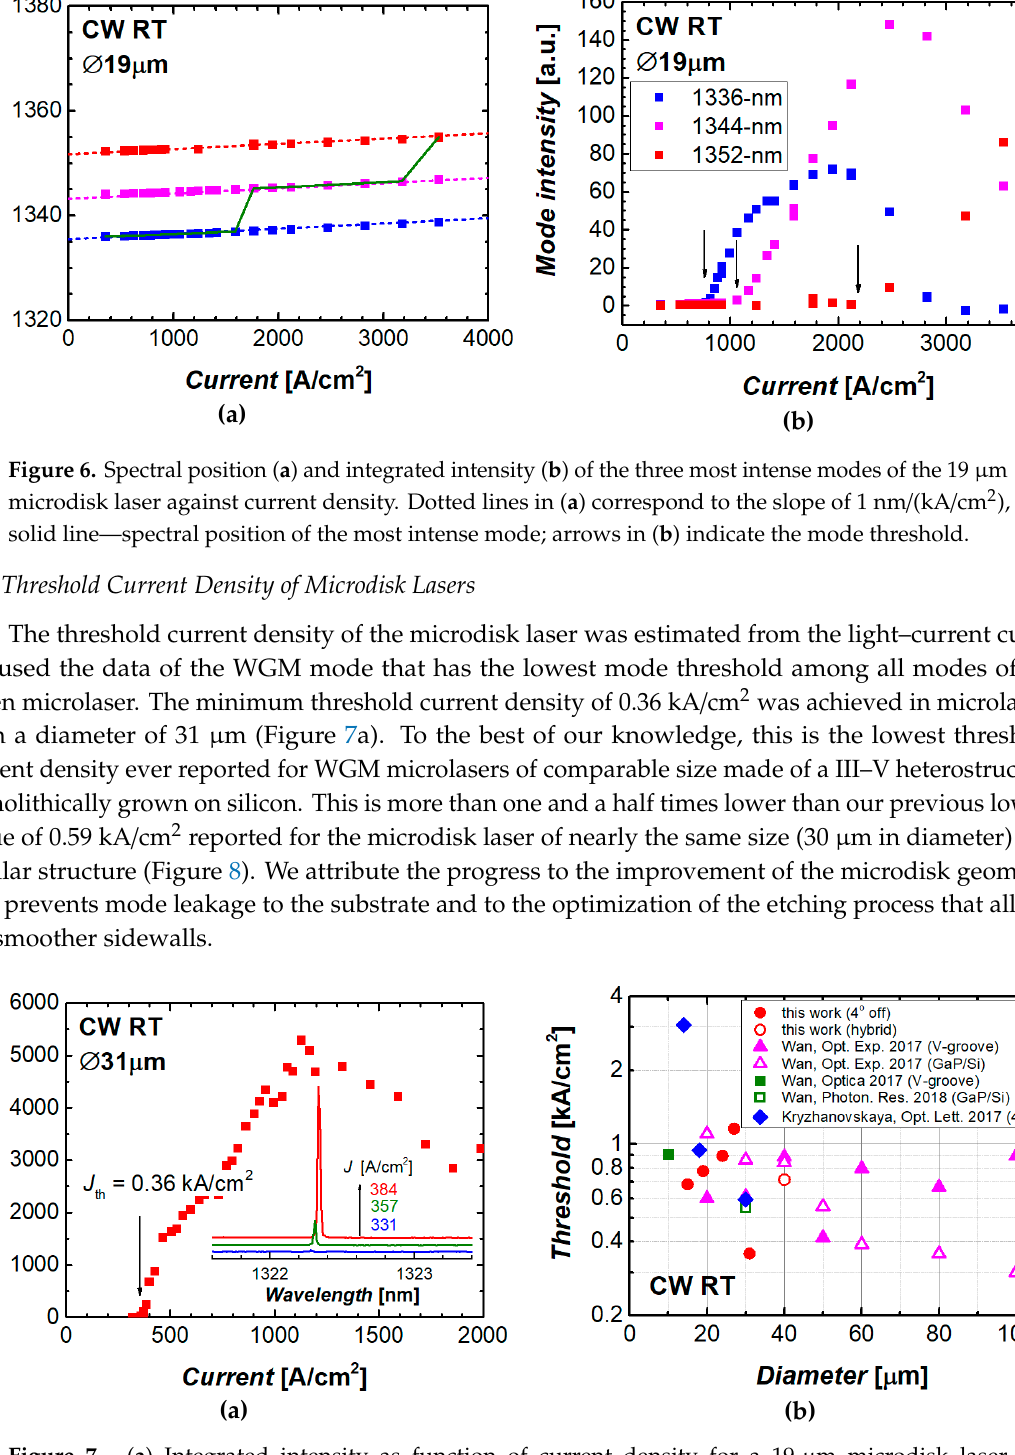
Figure 7. ( a ) Integrated intensity as function of current density for a 19- µ m microdisk laser. Inset: evolution of emission spectrum near the threshold; ( b ) lowest threshold current density of our microdisk lasers on silicon against diameter (solid and open circles: monolithic and hybrid integration, respectively) in comparison with published results on monolithic GaAs-based QD microdisk / microring lasers on Si.